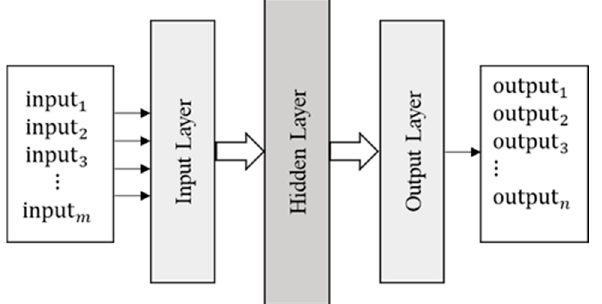
Figure 5. Architecture of the ANNs, consisting of the input, hidden, and output layer.